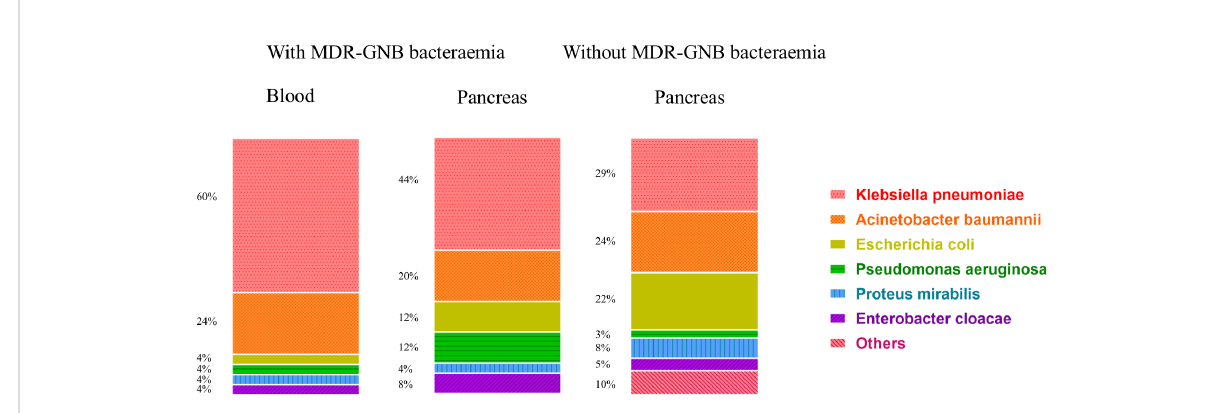
FIGURE 2 Distribution of 113 MDR-GNB strains among 72 IPN patients with and without bacteraemia. MDR-GNB, multiple drug-resistant Gram-negative bacterial; IPN, infected pancreatic